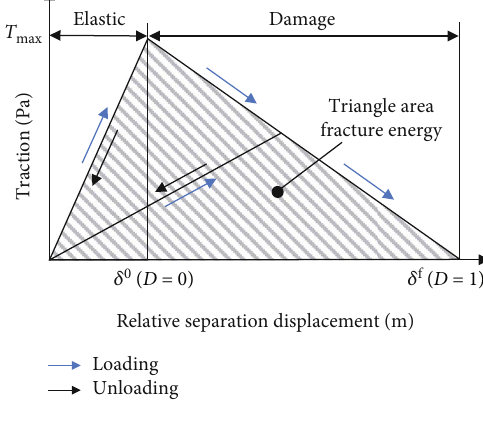
Figure 2: Bilinear traction-separation